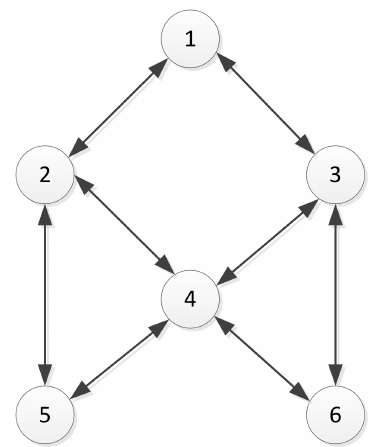
Figure 5. Communication topology of a typical formation with six unmanned aerial vehciles (UAVs). The circles represent the UAVs, the numbers in the circles are the UAV numbers, and the arrows indicate that there is communication between two